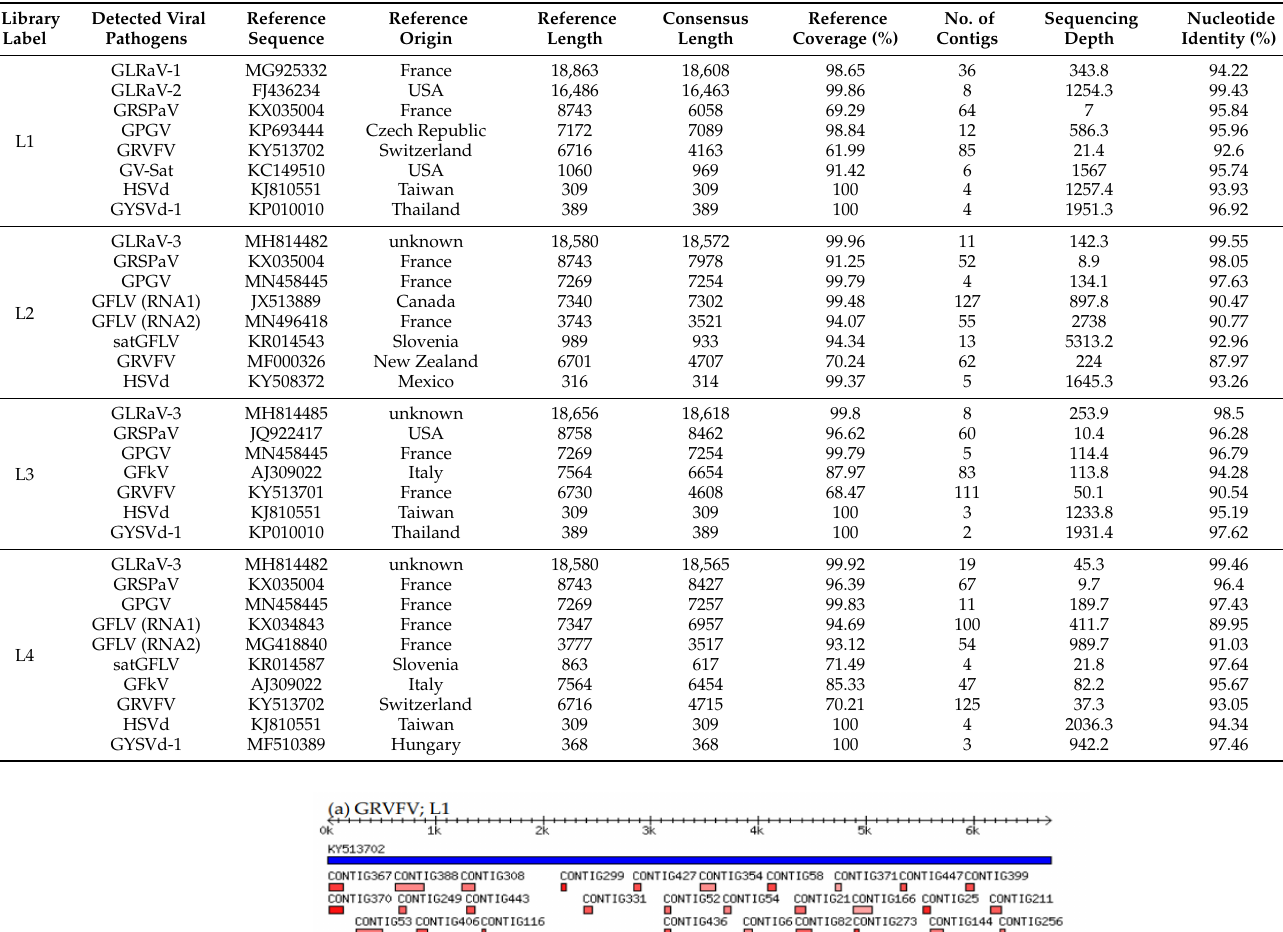
Table 3. Viruses and virus-like organisms detected with BLASTN search (VirusDetect pipeline).